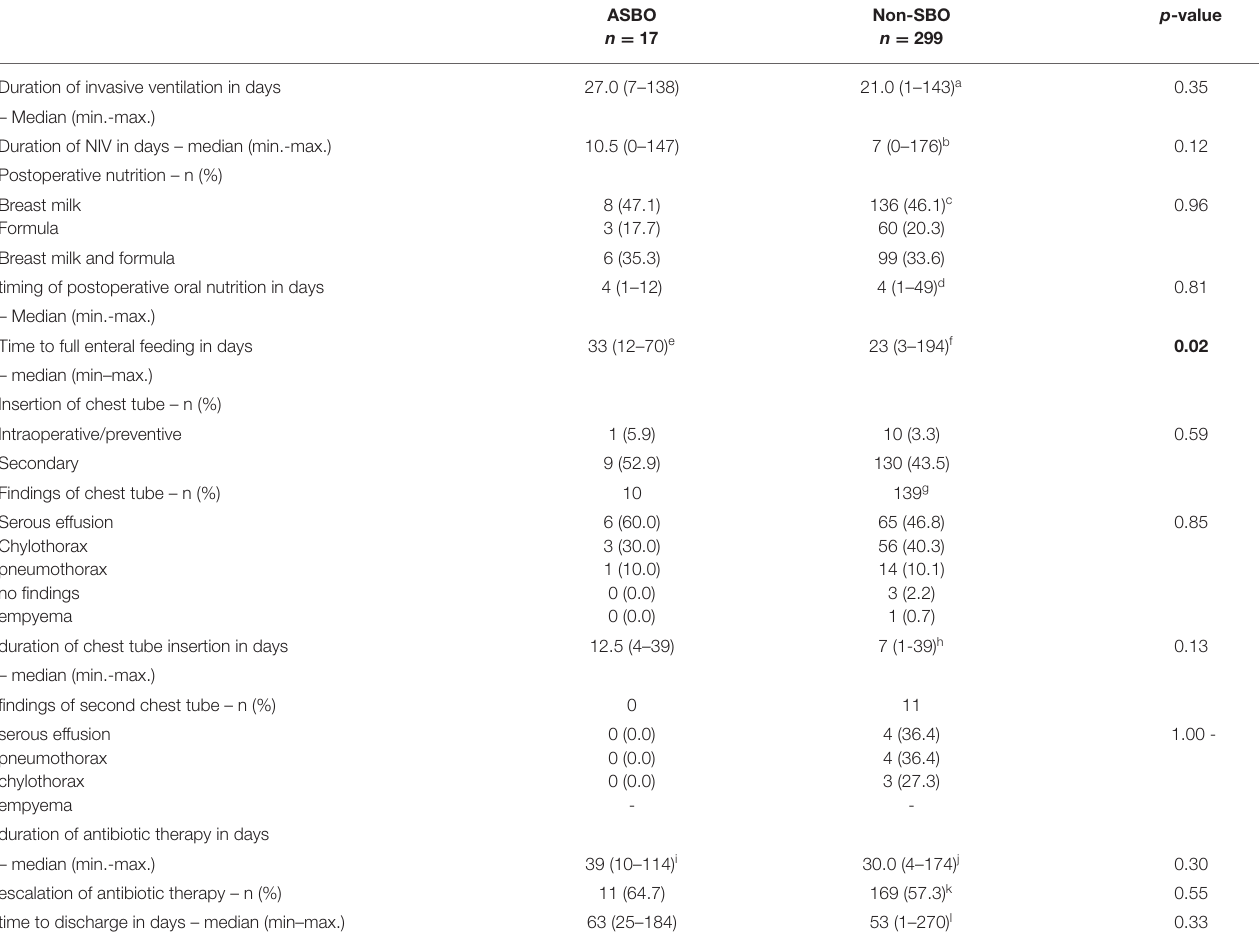
TABLE 7 | Differences in postoperative treatment between patients with ASBO and non-SBO.